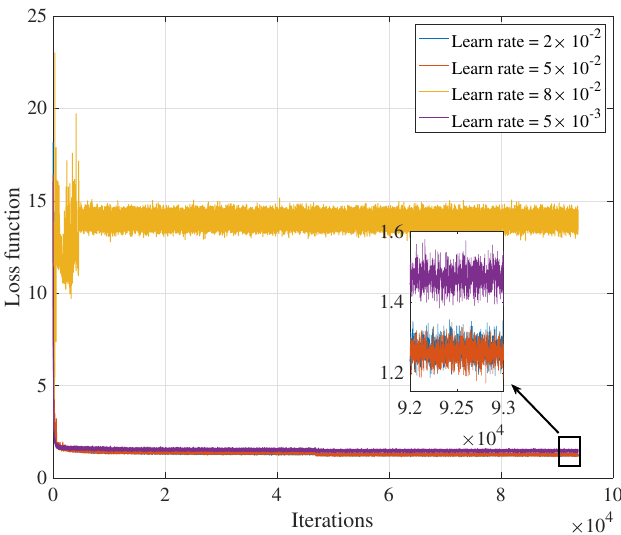
Figure 7. The loss function with different values of learning rate.